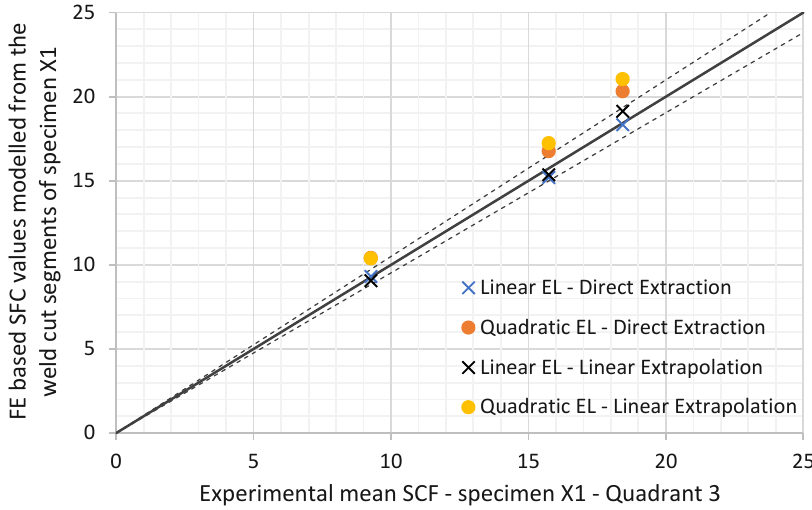
Figure 15. Direct and linear extrapolation of SCFs for first and second-order elements.